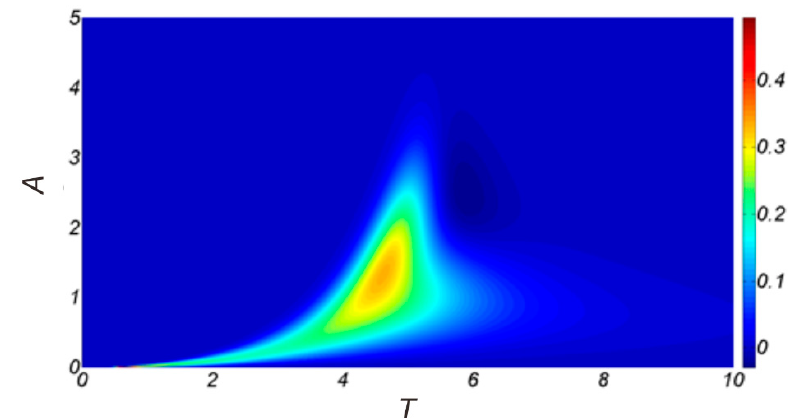
Figure 8. Joint distribution of wave amplitude and its associated period (reproduced from Park and Cho [17]).